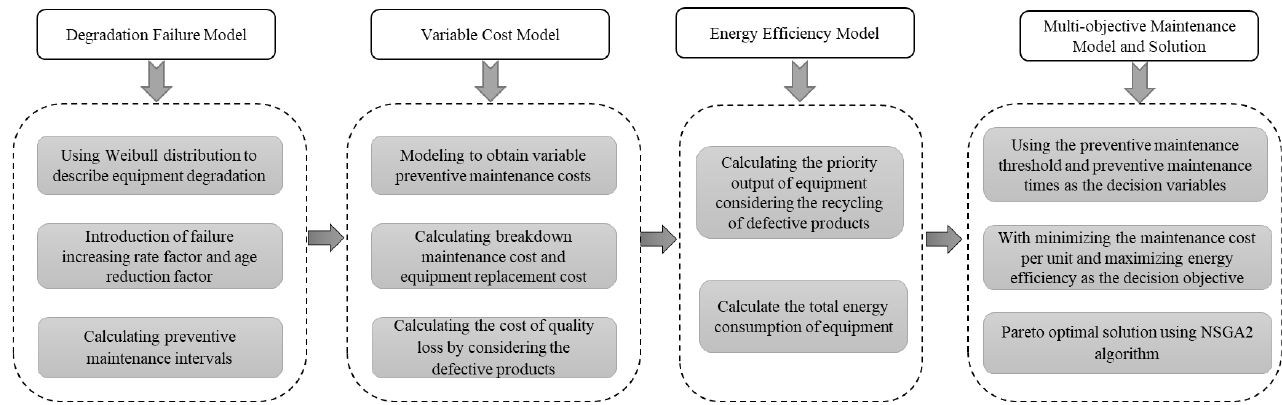
Figure 2. Modeling of the maintenance strategy optimization process.